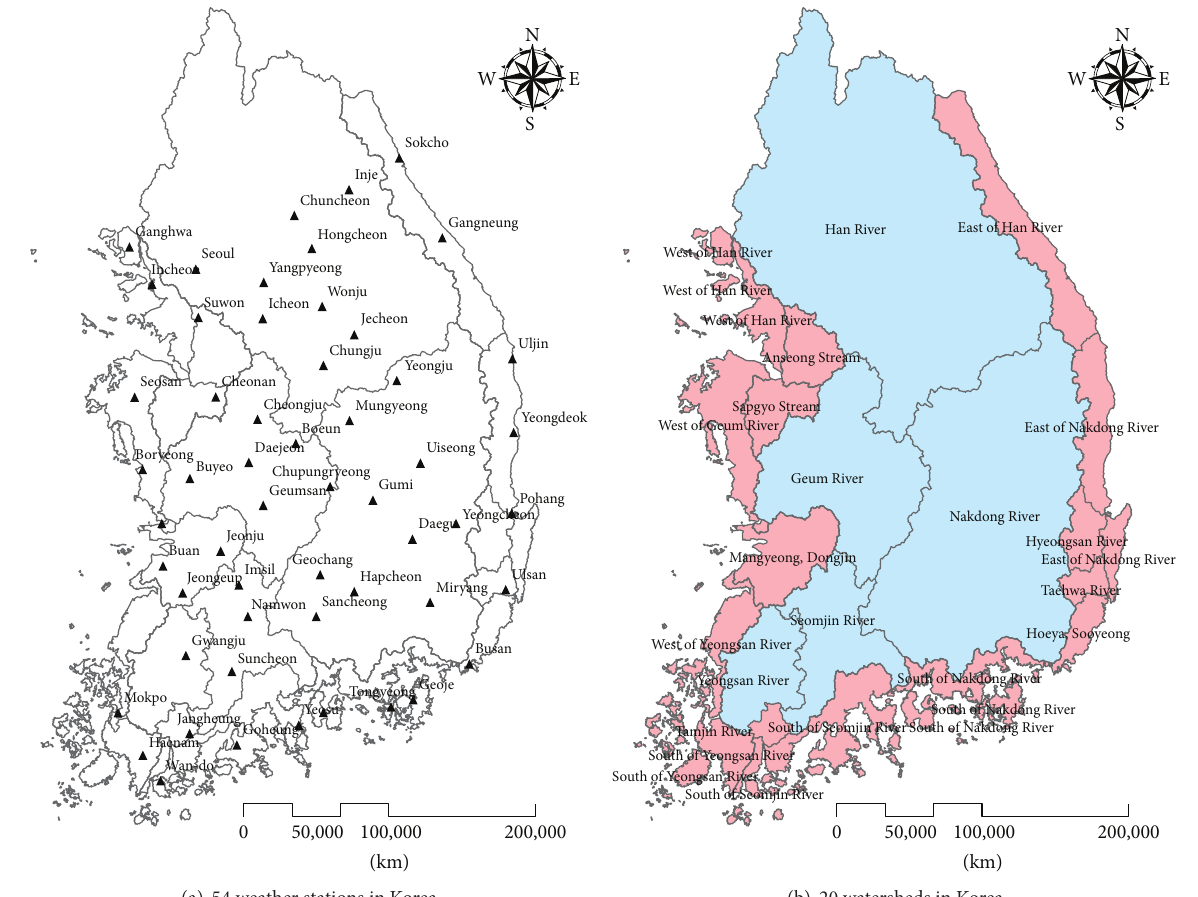
Figure 1: The locations of the 54 automated weather stations and the five major watersheds (Han River, Nakdong River, Geum River, Seomjin River, and Yeongsan River) of